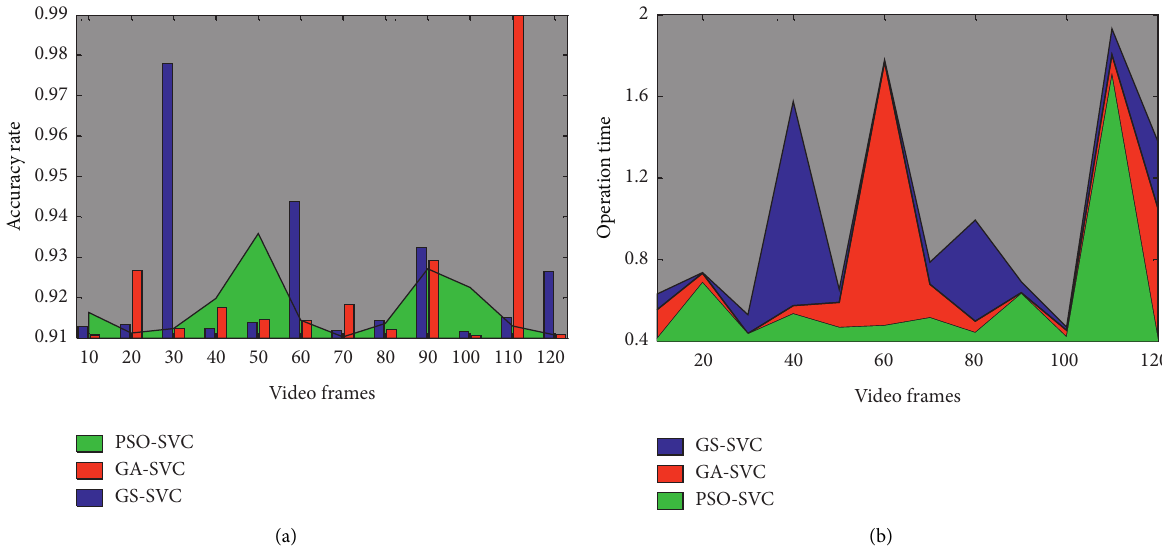
Figure 14: Two-classification model training and recognition results: (a) recognition accuracy rate; (b) time required.